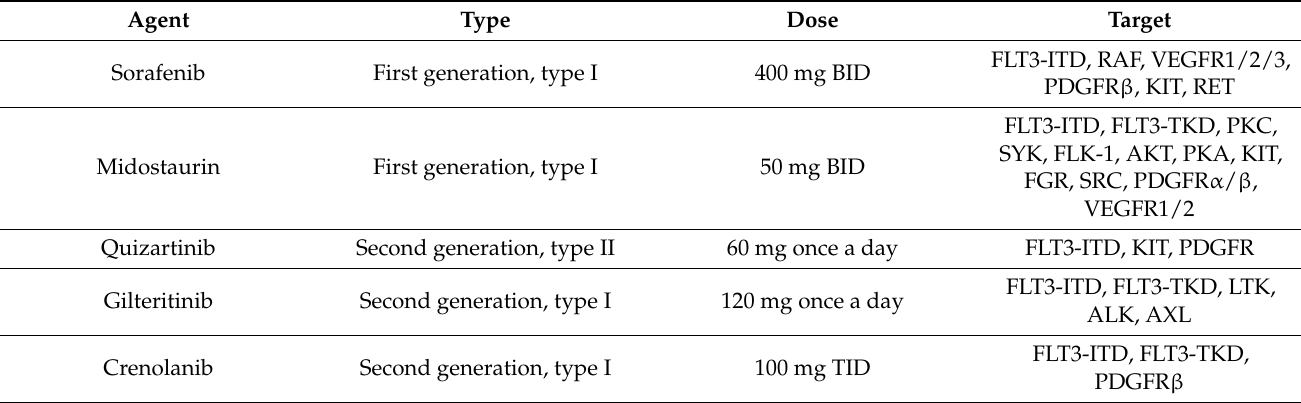
Table 1. FLT3 TKI spectrum